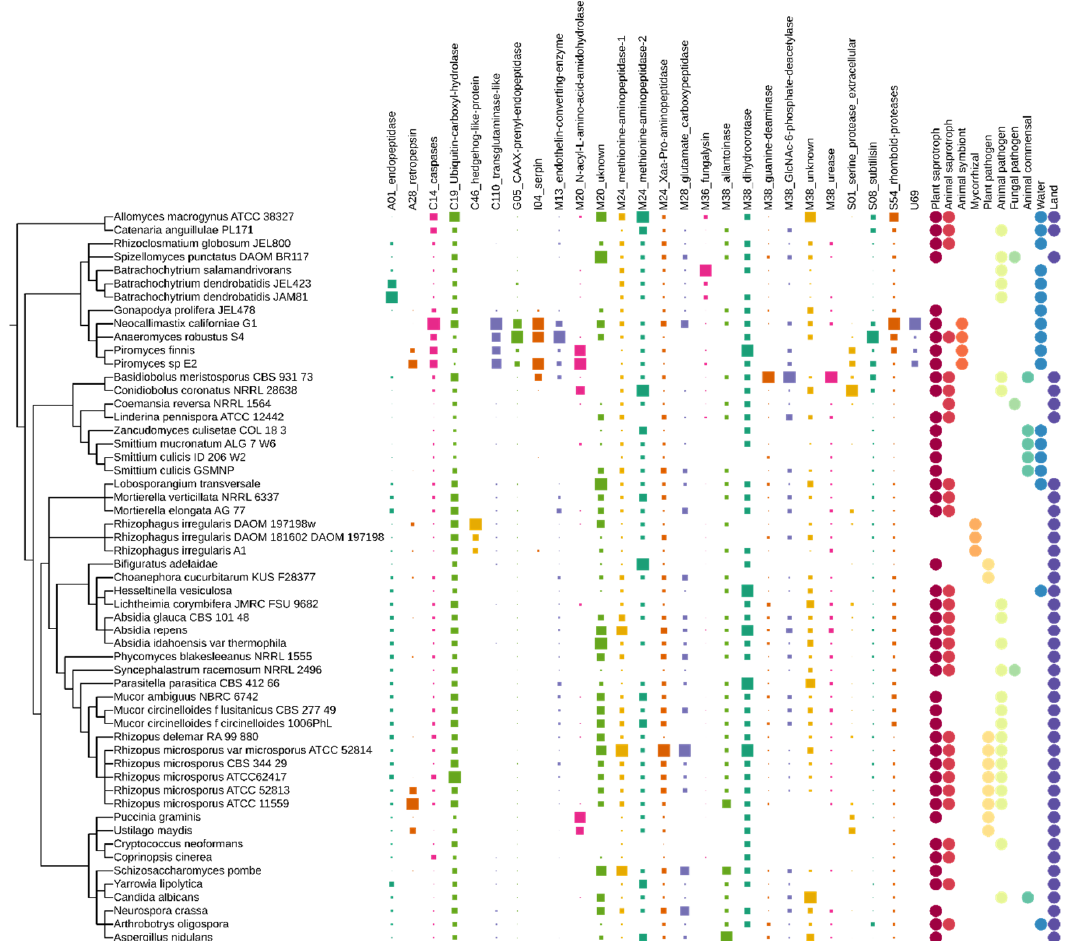
Figure 2. Distribution of adaptasome peptidases within early-diverging fungi. The presence of proteins belonging to a particular family is marked with squares of size corresponding to their copy number. Fungal ecology features are shown as circles.